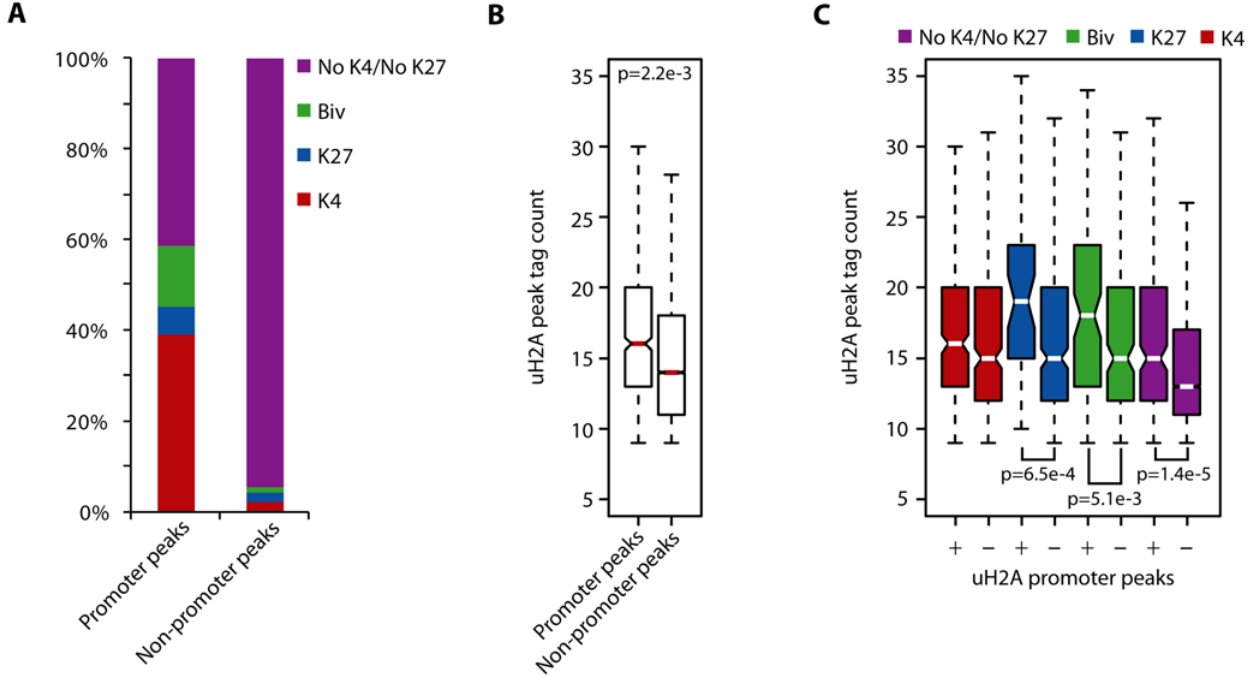
Figure 3. Promoter and non-promoter peaks of Bmi1-dependent uH2A are distinct. (A) Proportion of promoter uH2A peaks ( n =671) (left bar) and non-promoter uH2A peaks ( n =15735)(right bar) which overlap with H3K4/H3K27 methylation peaks. No K4/No K27, purple; both H3K4me3 and H3K27me3 (Bivalent), green; H3K27me3 only, blue; H3K4me3 only, red. (B) Box plot representation of peak tag density distribution for promoter and non-promoter uH2A peaks. Red lines indicate median values. P value derived from Wilcoxon signed-rank test. (C) Box plot representation of peak tag density distribution for promoter ( + ) and non-promoter ( 2 ) uH2A peaks further sub-divided by H3K4me3/H3K27me3 co-localization. No K4/ No K27, purple; both H3K4me3 and H3K27me3 (Bivalent), green; H3K27me3 only, blue; H3K4me3 only, red. White lines indicate median values. P value derived from Wilcoxon signed-rank test.